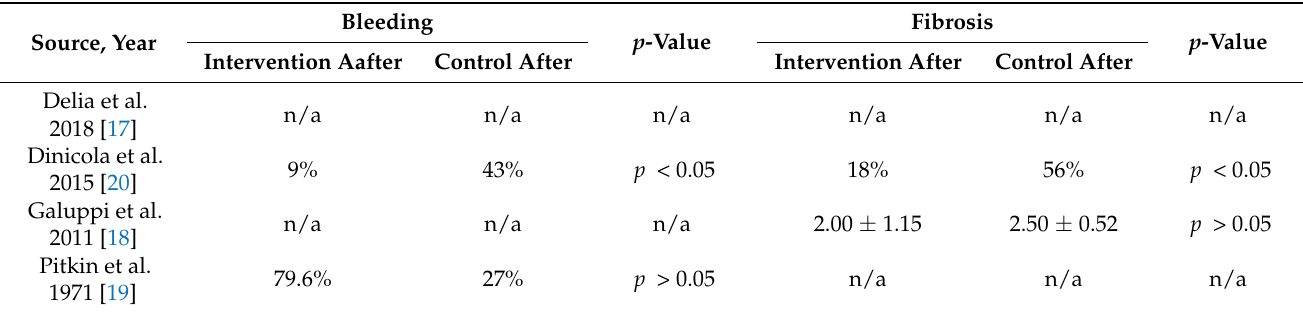
Table 4. Effect of intervention on vaginal